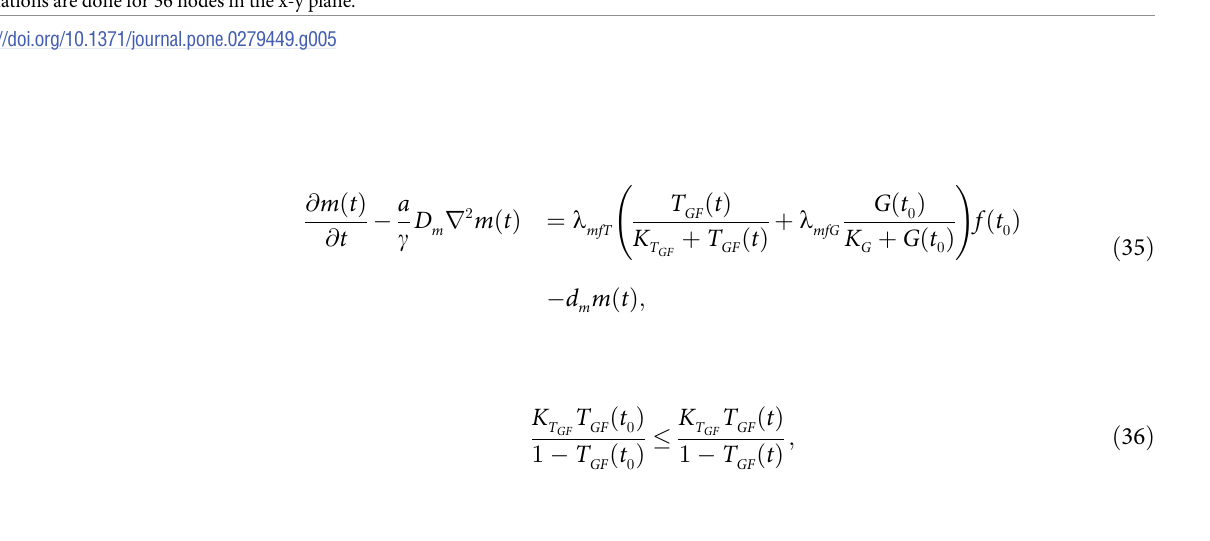
Fig 5. The optimal control function for TGF- β . The second model problem (7)–(9)is solved. Graphs of optimal TGF- β are depicted for dt = 0.1, 0.5, 10, 15. As is shown, the Euler approximation and the scipy.linalg package has almost the same results. However, since TGF- β in the real world can not take negative values, one finds out that the second model problem (7)–(9) must be improved. In solving the central finite differences explicit method, all calculations are done for 36 nodes in the x-y